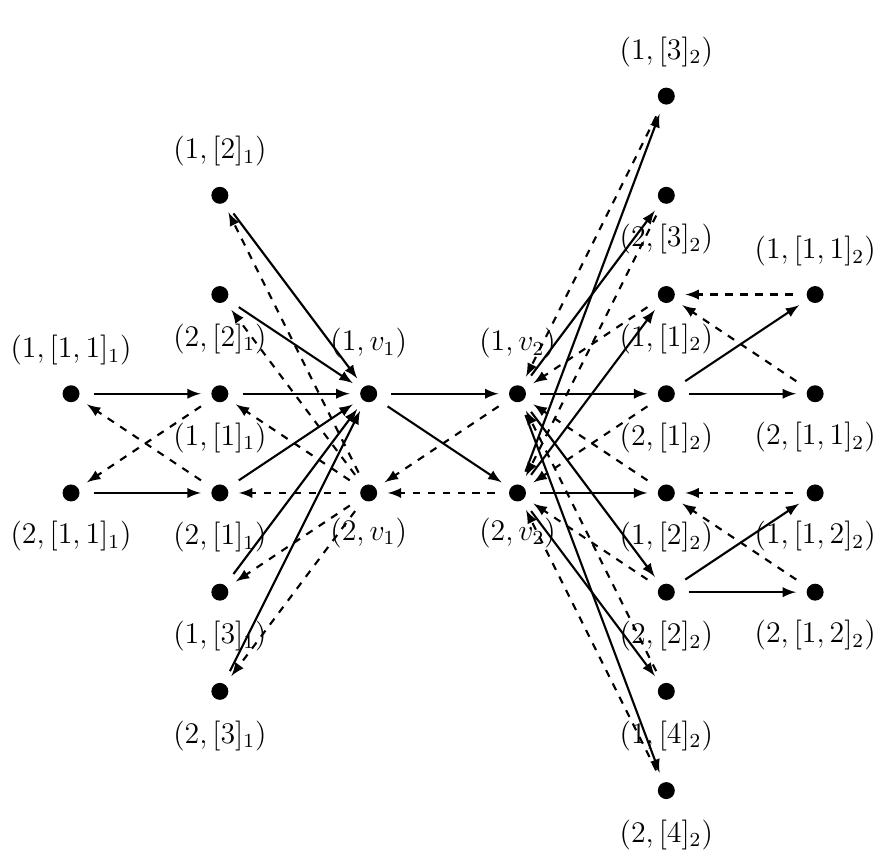
Figure 3: Orientation D for H